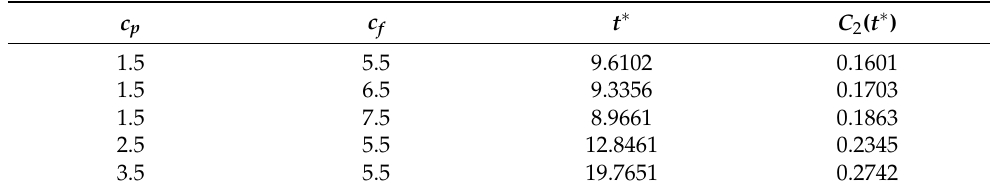
Figure 8. Cost function under different parameters. Table 6. Optimal solution with different values of cost parameters when n = 5, k = 2, p = 0.45, δ = 2, m 1 =